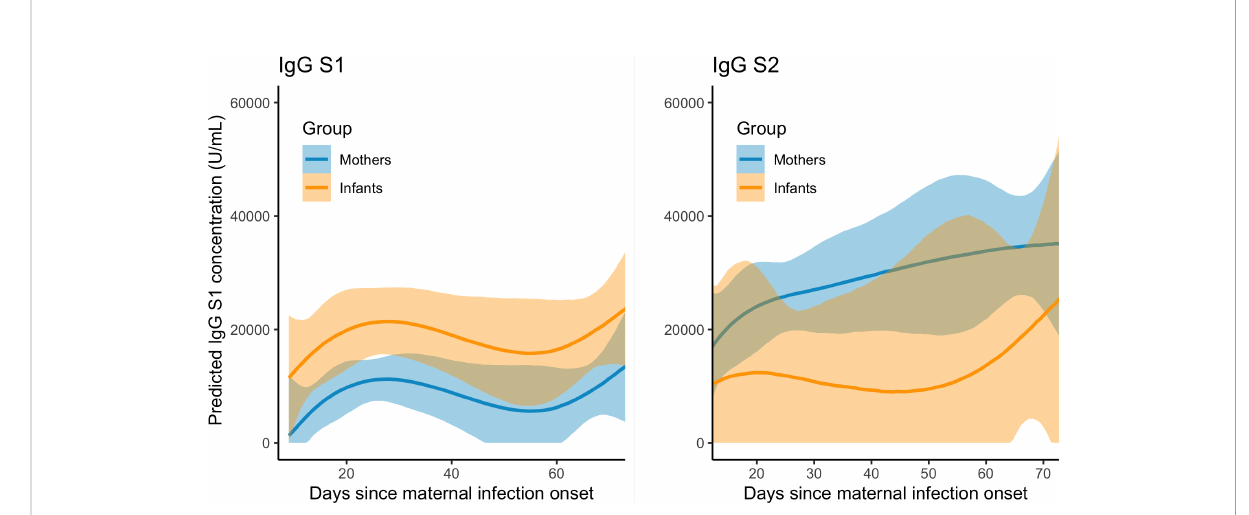
FIGURE 5 Predicted IgG S1 and S2 concentration (with 95% credible intervals) in COVID+ mothers (n = 26, n obs = 66) and exposed infants (n = 9, n obs =17) over two months following maternal infection onset.